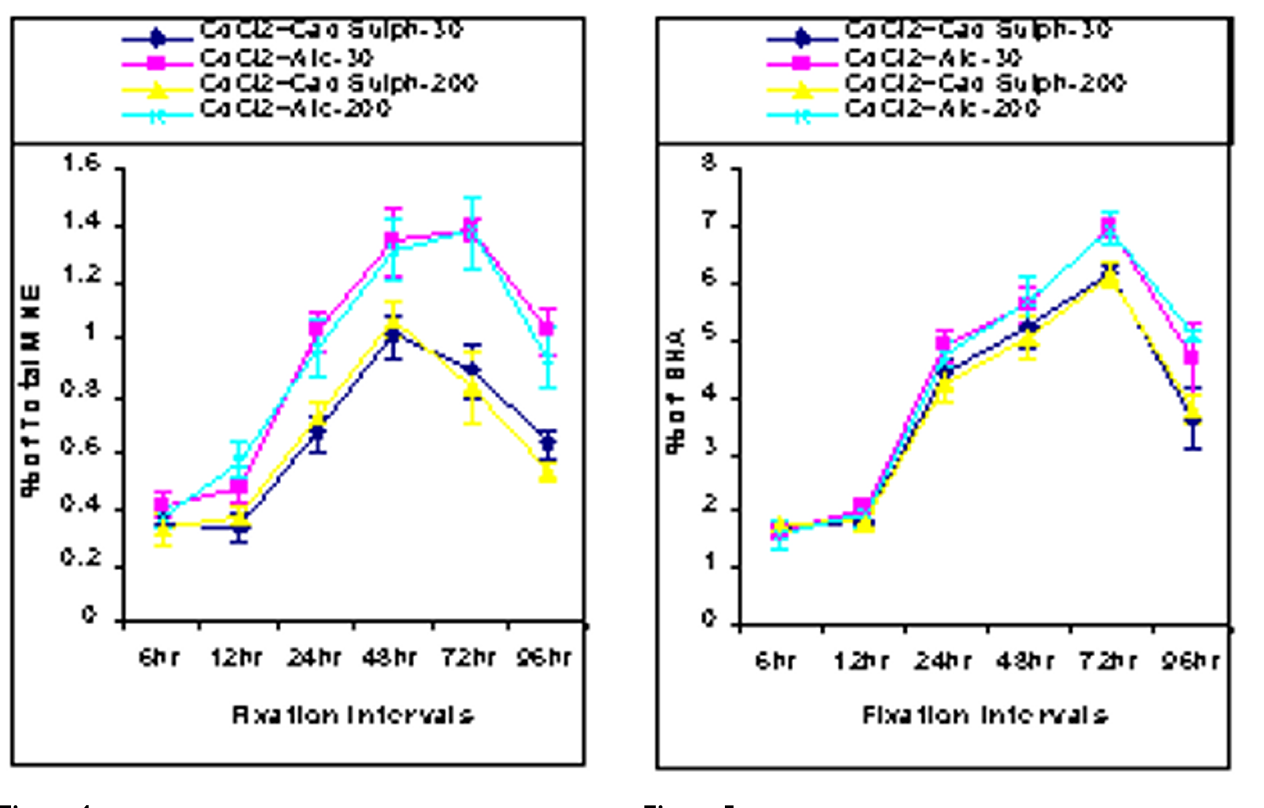
Figure 4 Showing time-dependent frequencies of Cad Sulph-30 pre- fed and Cad Sulph-200 pre-fed series versus their respective CdCl 2 treated alcohol-30 and alcohol-200 control mice.